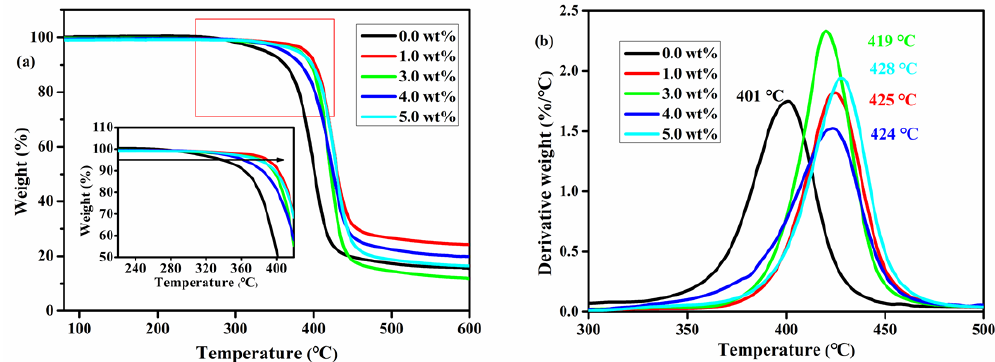
Figure 6. TGA and Differential thermal gravity (DTG) curves of neat epoxy and its composites.